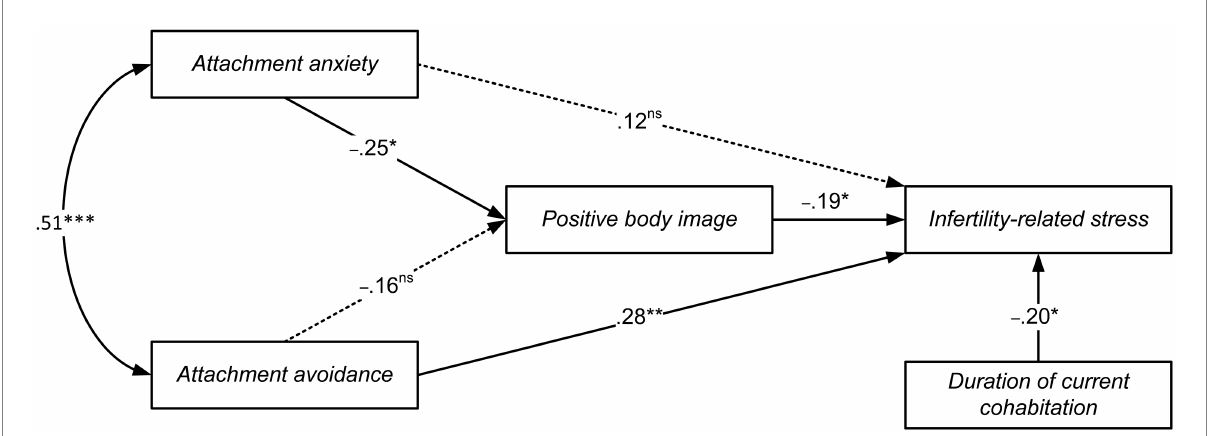
FIGURE 3 Path analysis of the relationship between attachment anxiety, attachment avoidance, and infertility-related stress, as mediated by positive body image. Path coefficients are standardized; Not significant paths are represented with dotted lines; ns = not significant; * p < 0.05, ** p < 0.01, *** p < 0